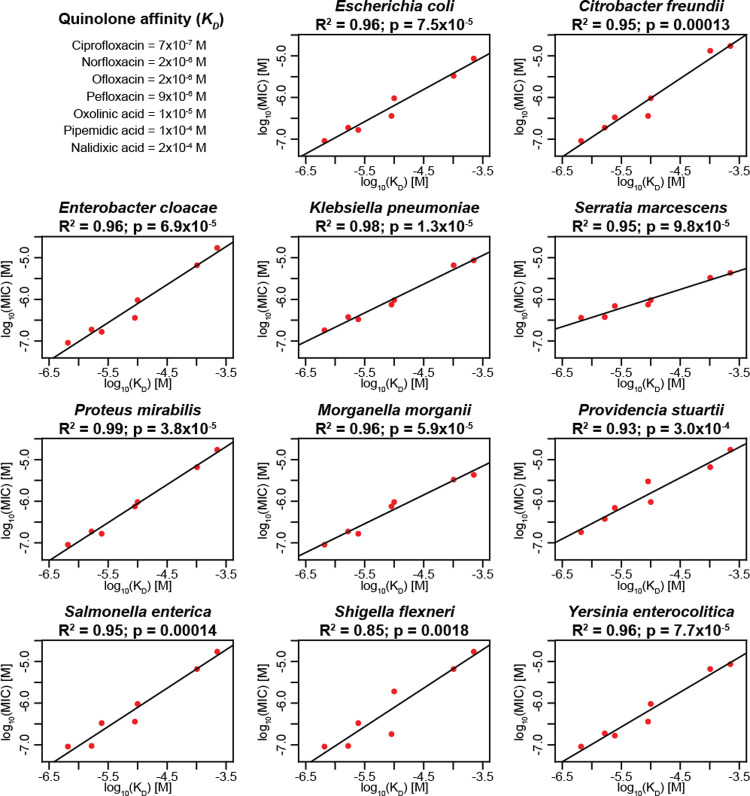
Clinical data confirm linear correlation between MICs and affinities of quinolones to gyrase.We analyzed MIC and drug-target affinity data from 11 Enterobacteriaceae isolates and seven different quinolones. The x-axes show the affinities (KD) as reported in the literature [24, 26–28], and the y-axes show the MICs, both in mol/L. The adjusted R2 and p-value of each correlation are given. In cases where there was more than one KD value reported in the literature, we used the mean for this analysis. The tested MIC values are the median of several clinical isolates described previously [28].